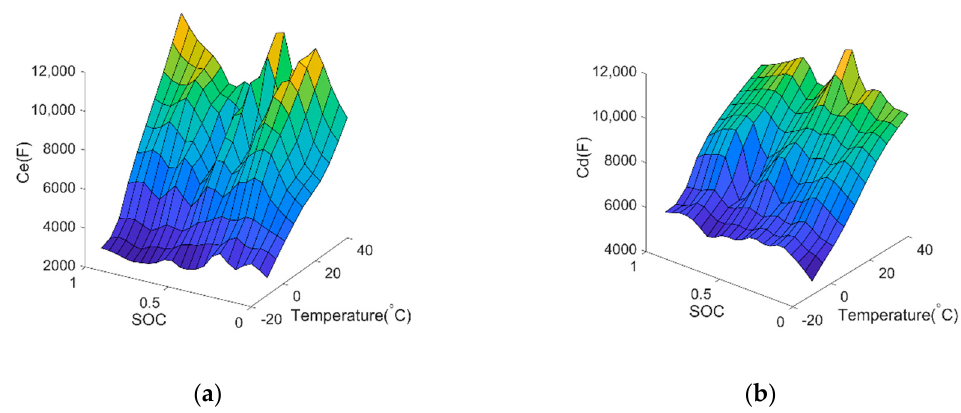
Figure 9. Polarization capacitance identification results at different temperatures: ( a ) Electrochemical polarization capacitor; ( b ) concentration polarization capacitor.